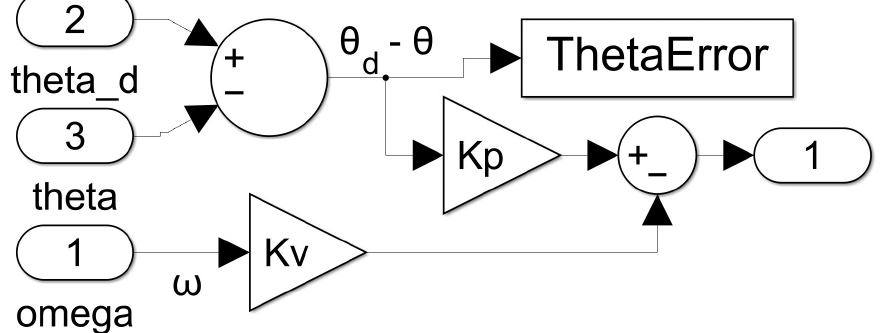
Figure A8. Simulink implementation of a P+V feedback